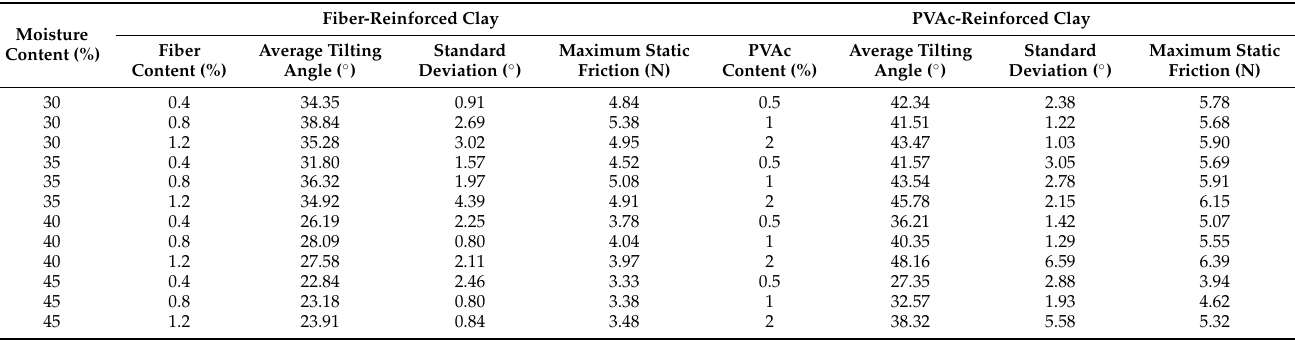
Figure 4. Model test result of sisal fiber-reinforced clay: ( a ) The tilting angle of clay sample; ( b ) Maximum static friction of clay sample. Table 5. Clay sample descriptions of model